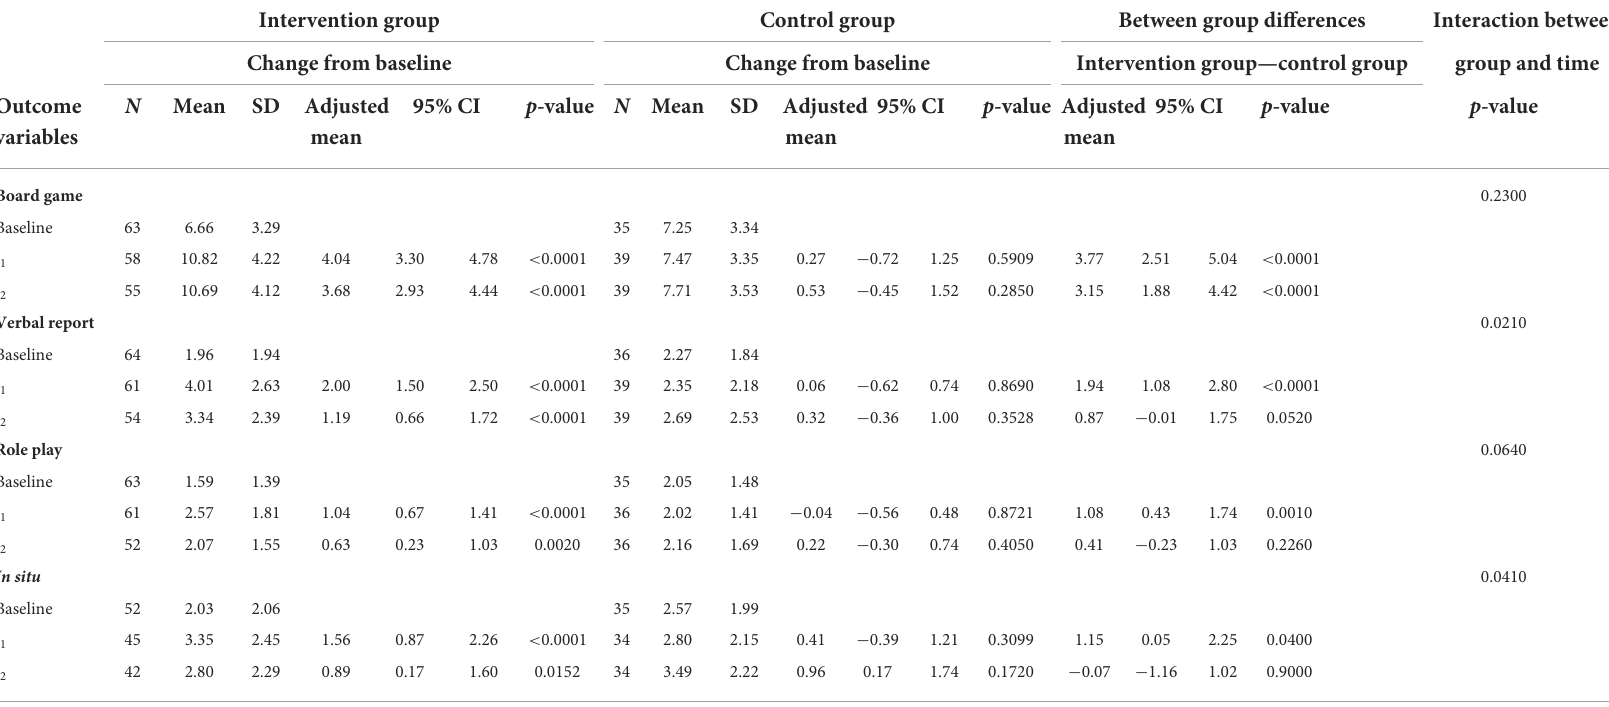
TABLE 2 Changes in prevention knowledge (Board Game, Verbal Report) and prevention behavior (Role Play, in situ ) for intention to treat analysis, baseline adjusted measures, Baseline—before intervention, t1—after intervention, t2—3 months after intervention, Range Board game 0–25, Ranges other measures